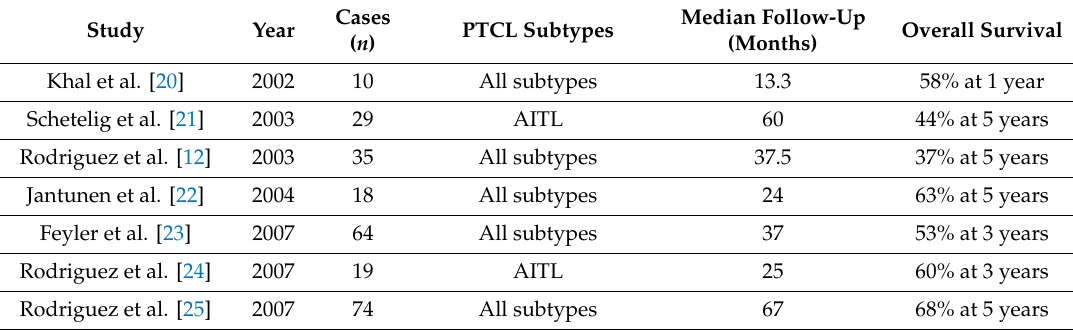
Table 4. Autologous stem cell transplantation in the frontline setting: retrospective